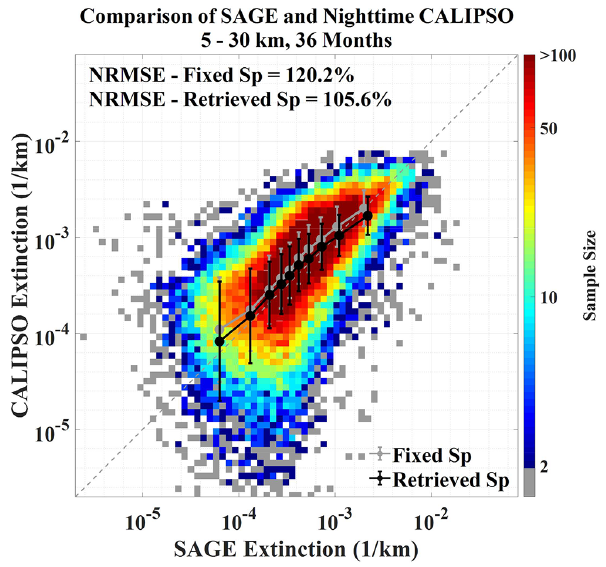
Figure 9. The coloured scatter plot is the same as that in Fig. 5a, but the CALIPSO extinction is retrieved using fixed lidar ratios of 50 and 28.75sr in the stratosphere and troposphere from June 2017 to May 2020, respectively. The grey and black lines are the mean value of each 10% quantile (as in Fig. 5a) of the CALIPSO retrieved extinction using the fixed lidar ratios and our retrieved lidar ratios, respectively. The I-type bars indicate the standard deviation of the CALIPSO retrieval at each 10%